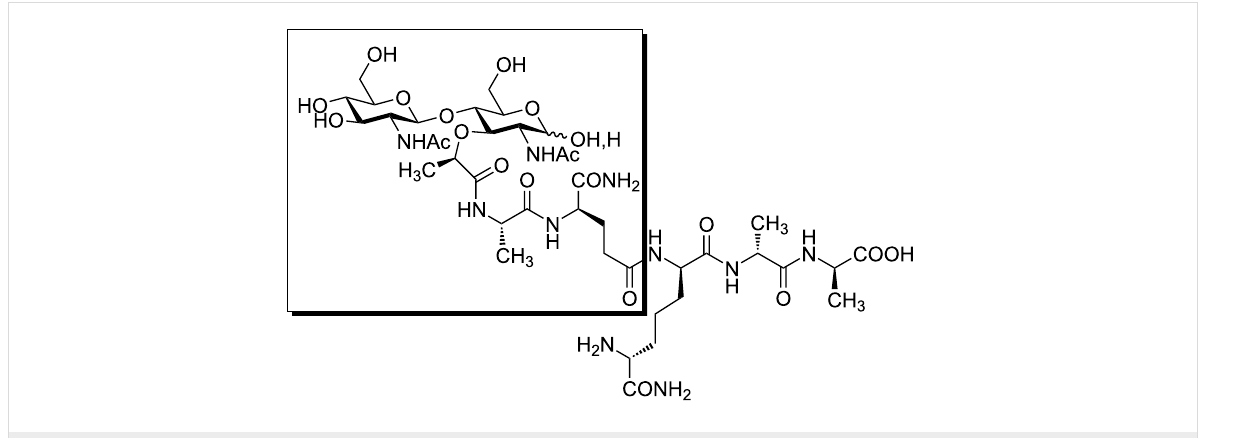
Figure 1: Peptidoglycan fragments with immunostimulating properties.